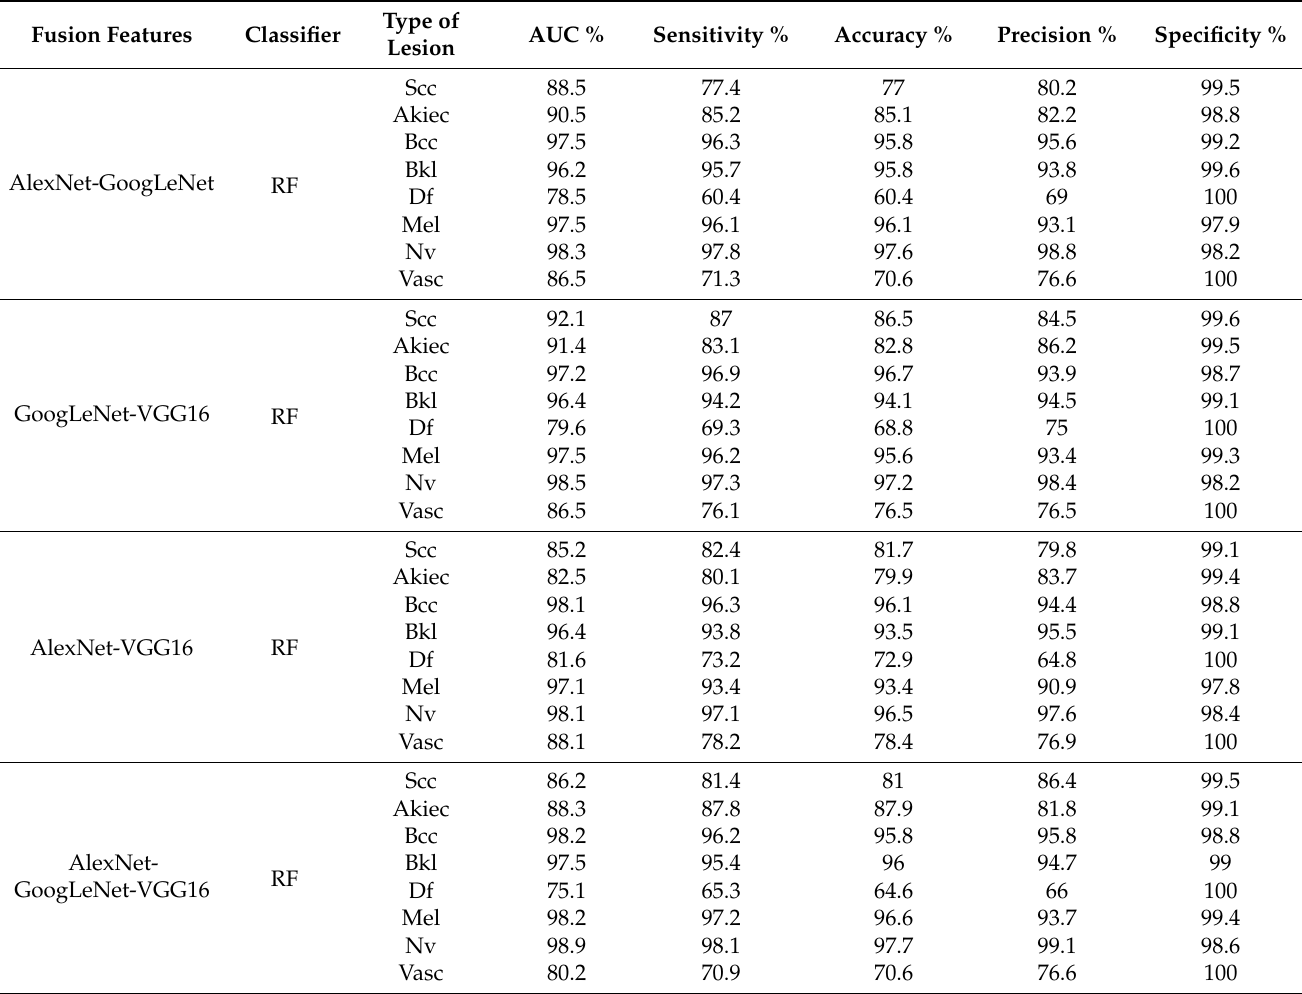
Table 8. Performance results of CNN-RF hybrid models based on the fused CNN models for early diagnosis and differentiation of skin cancer and other skin